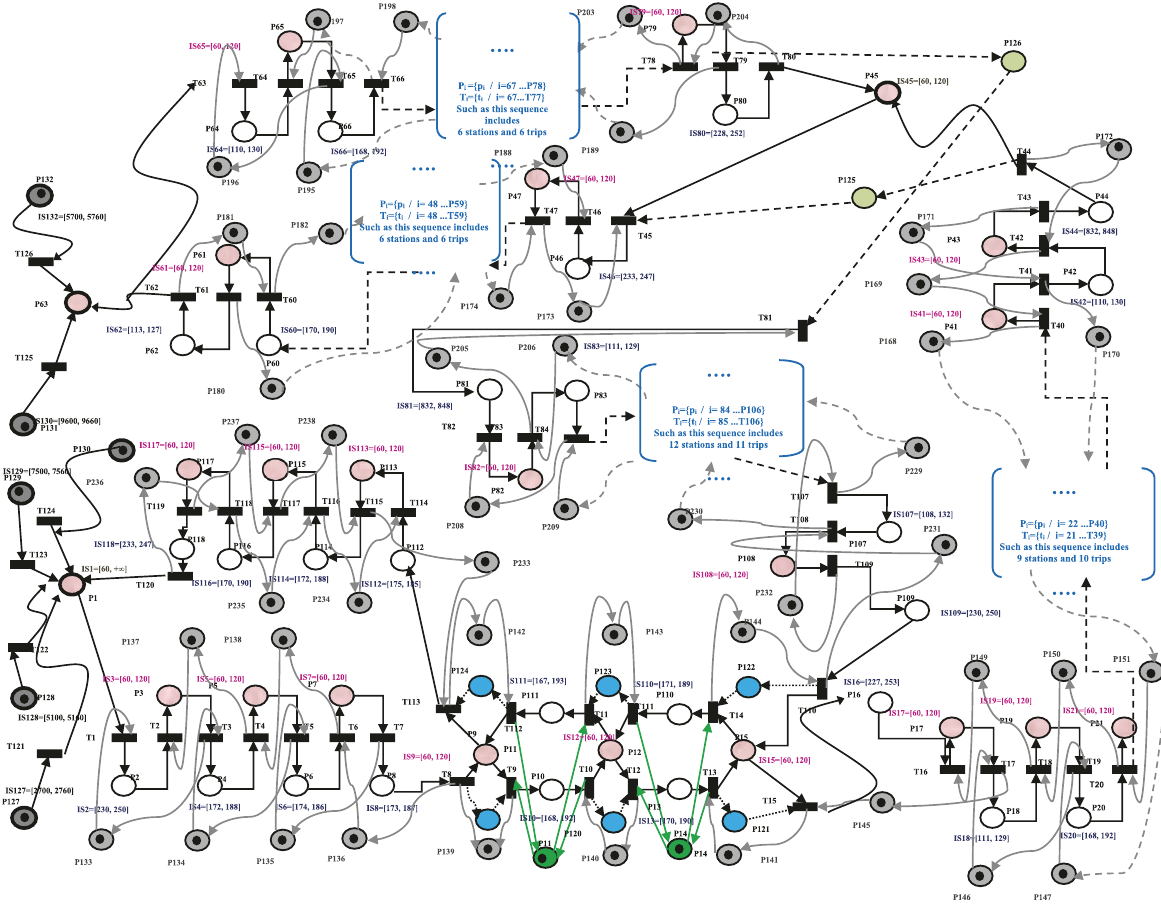
Figure 7: P-TPN model for the Sahel railway network